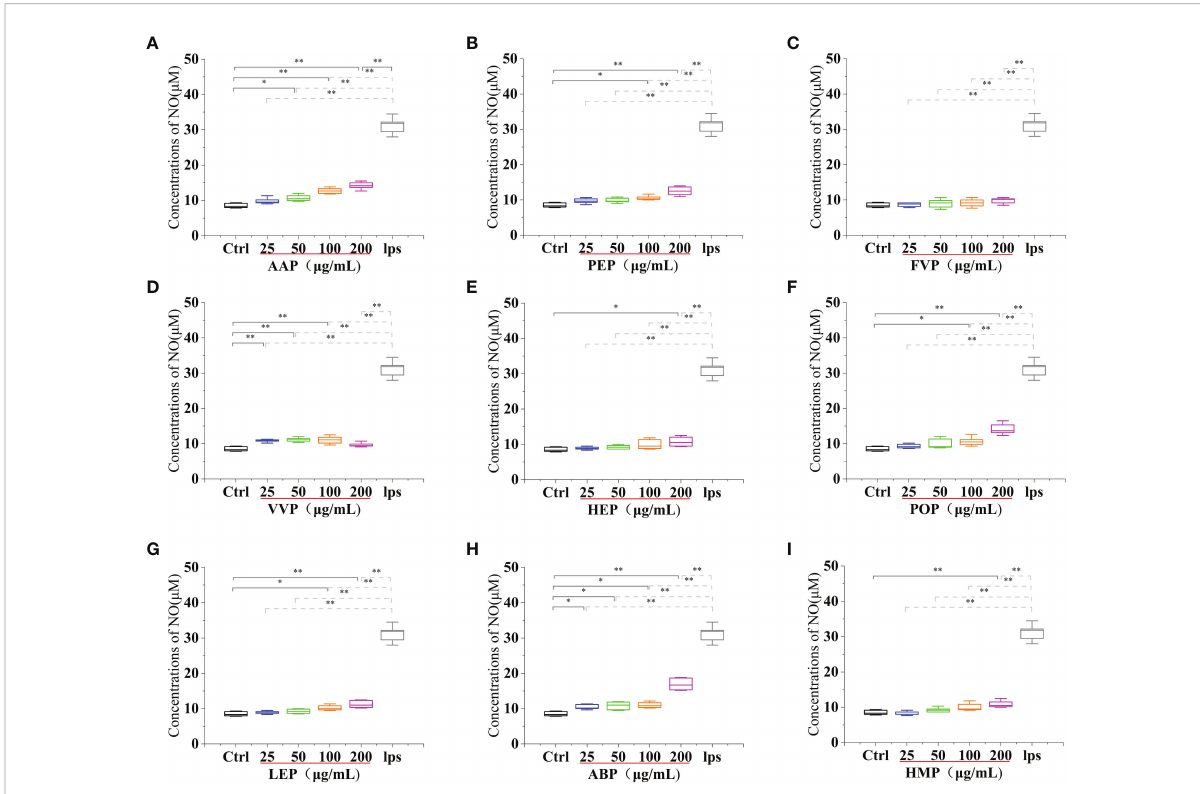
FIGURE 8 Effect of different edible mushroom protein treatments on NO production in RAW 264.7 cells AAP (A) , PEP (B) , FVP (C) , VVP (D) , HEP (E) , POP (F) , LEP (G) , ABP (H) and HMP (I) on RAW 264.7 cells for NO production. Data are expressed as mean ± SD (n = 5). *P <0.05 and **P < 0.01 compared to the control